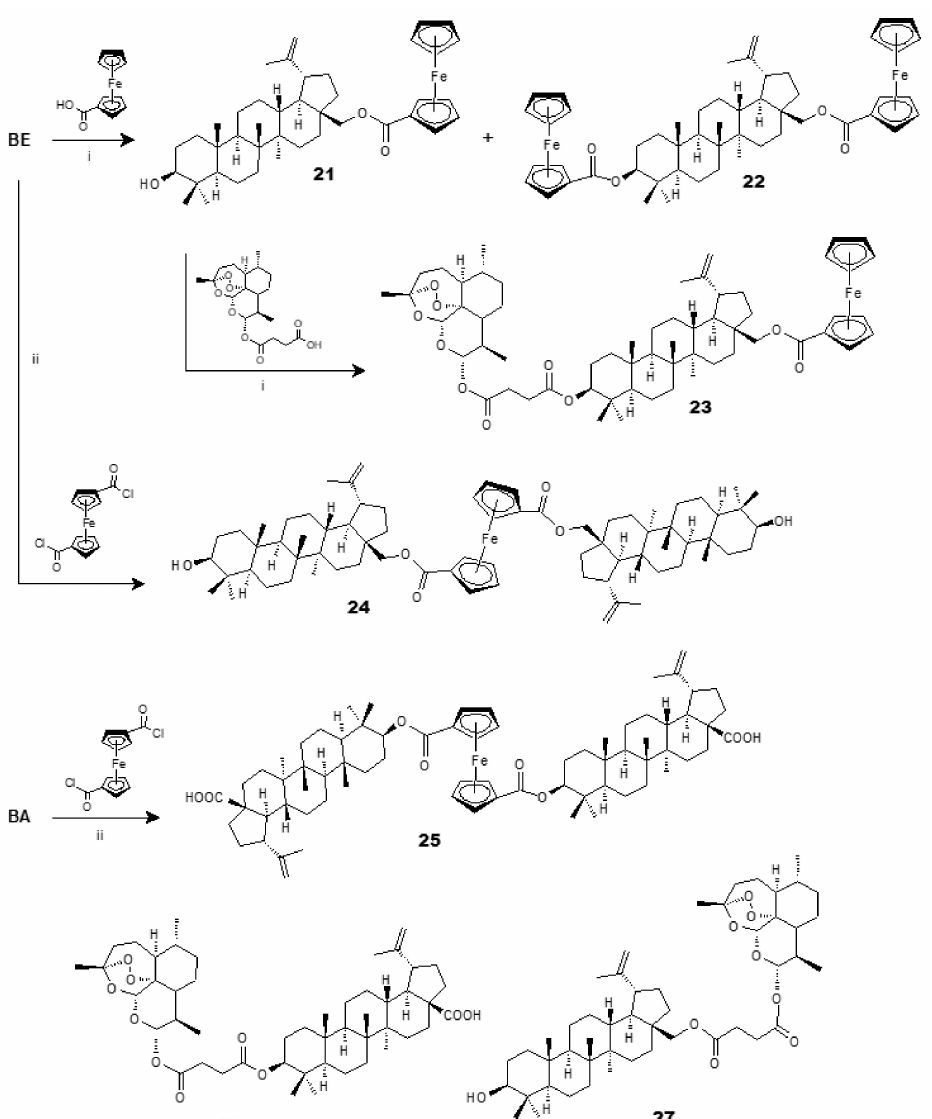
Scheme 7. Synthetic routes to BA/BE-derived dimers and hybrids 21 – 25 . Reagents and